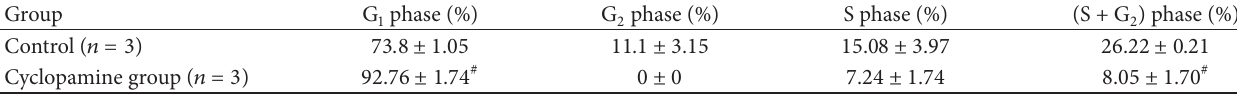
Table 2: Effect of cyclopamine on the cell cycle of cultured FLS from RA patients using flow cytometry.